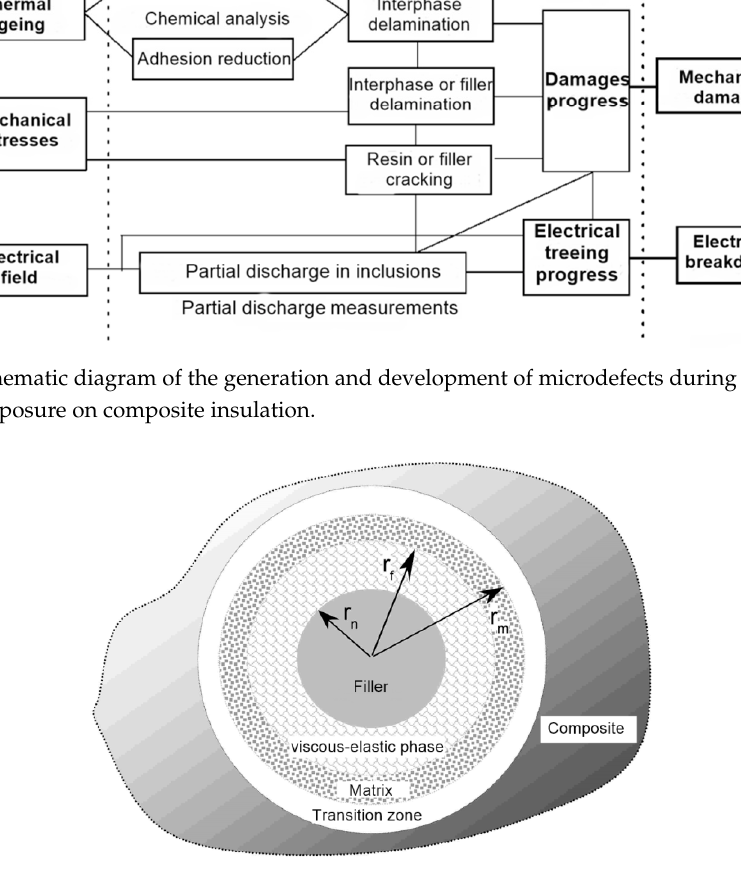
Figure 1. Schematic diagram of the generation and development of microdefects during the impact of combined exposure on composite insulation.